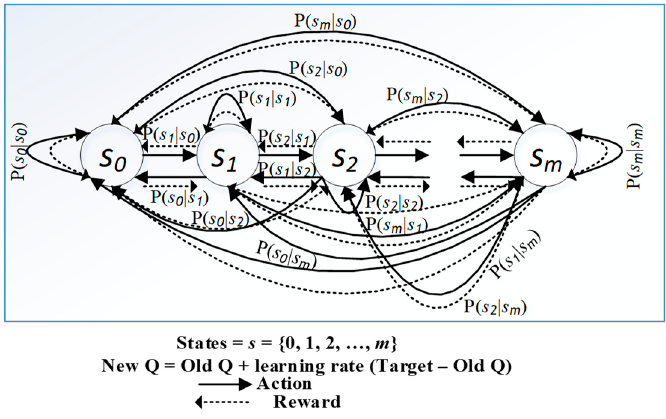
Figure 1. State-transition diagram for Markov decision process (MDP) with m states.